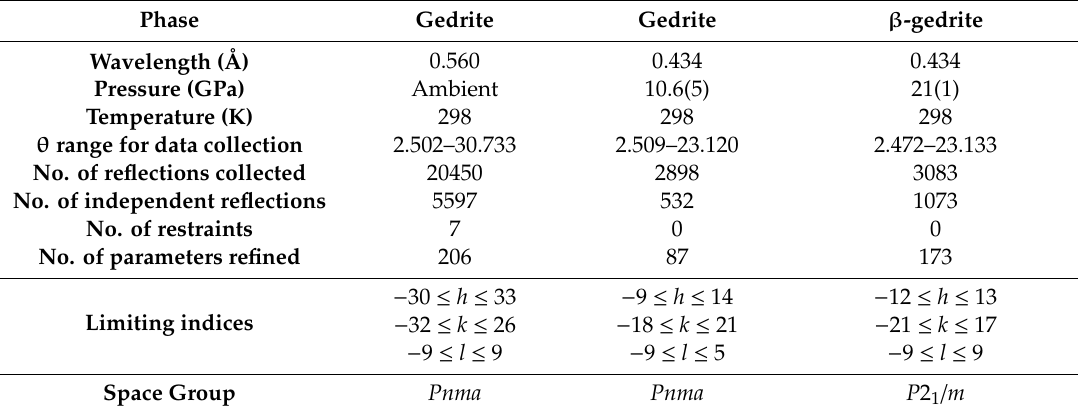
Table 2. Representative single-crystal structure refinement parameters for gedrite at selected